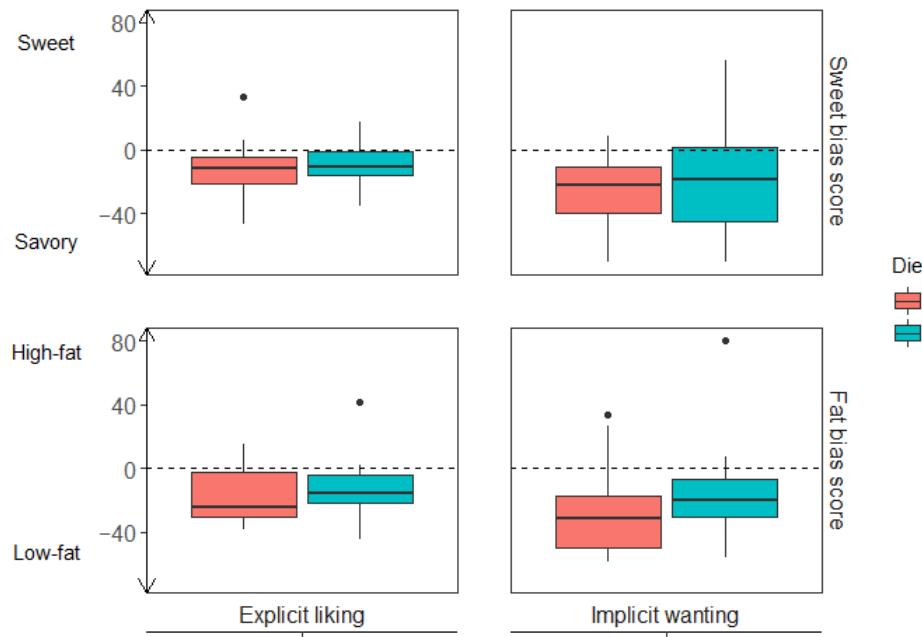
Figure 3. Sweet and fat bias scores stratified by diet group (TID and WD). Upper panel (Sweet bias): explicit liking (left, n = 44) and implicit wanting (right, n = 43) for sweet relative to savoury foods where scores below zero indicate preferences for savoury over sweet. Lower panel (fat bias): explicit liking (left, n = 44) and implicit wanting (right, n = 43) for high-fat relative to low-fat foods where scores below zero indicate preferences for low-fat over high-fat. Coloured boxes represent median and IQR, whiskers represent Q − 1.5*IQR and Q3 + 1.5*IQR, and dots represent outliers. WD, Westernised diet; TID, traditional Inuit diet; IQR, interquartile